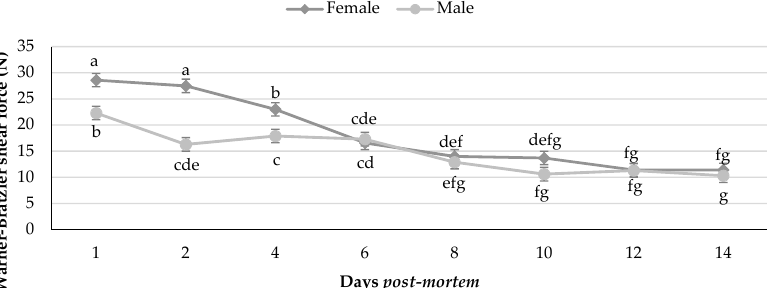
Figure 6. Effect of sex and ageing (days post-mortem ) on the Warner–Bratzler shear force (N) of female and male impala longissimus thoracis et lumborum muscles. a–h Means with different superscripts differ from one another ( p ≤ 0.05). Error bars represent the standard error of the means.